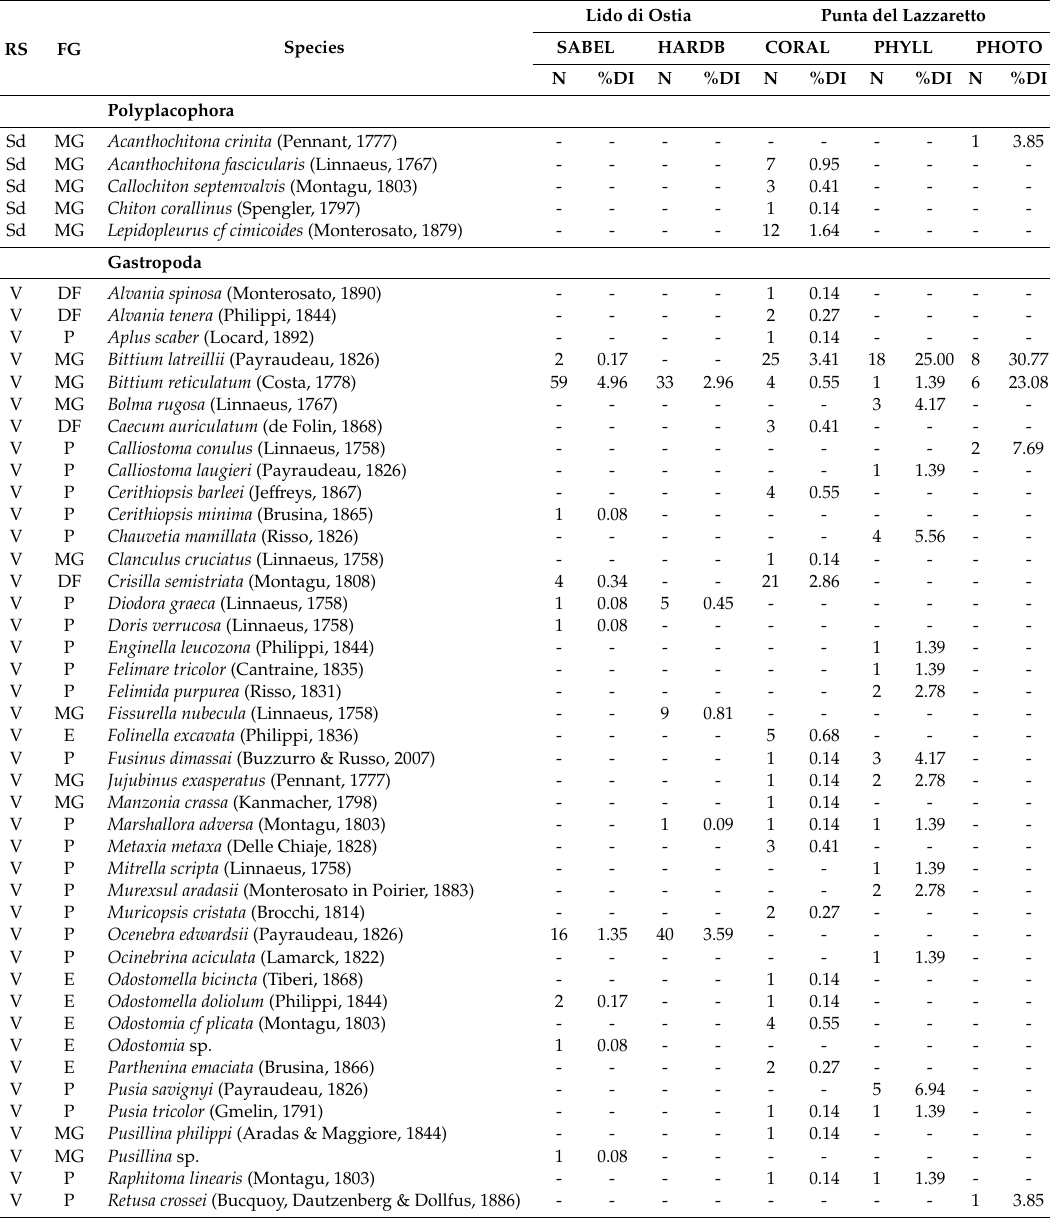
Table 1. Taxonomic list of species, occurring in each habitat (SABEL— S. alveolata reef; HARDB—hard bottom with photophilic algae; CORAL—coralligenous concretion; PHYLL— P. crispa sciaphilic assemblage; PHOTO—shallow photophilic assemblage), with their abundance (N), quantitative dominance (%DI), feeding guilds (MG Micro- and Macro-grazers, DF Deposit feeders, P Predators, E Ectoparasites, SC Scavengers, SF Suspension feeders) and relation with substrates (RS: V vagile, Sd sedentary, Ss